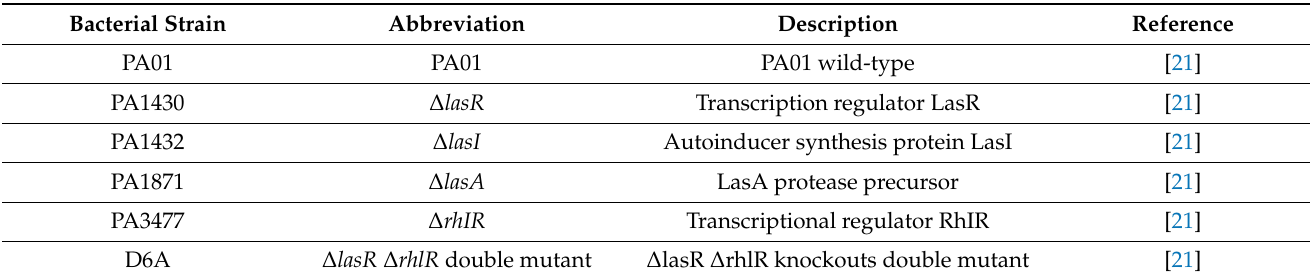
Table 1. Bacterial strains used in this